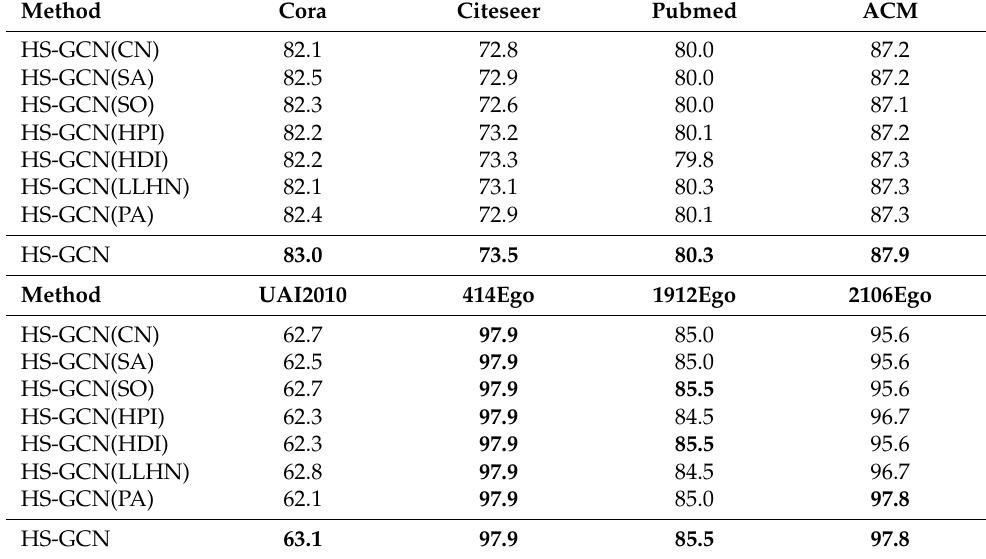
Table 4. The results (max %) of node classification for low order similarity methods. (Bold: best performance for each dataset).